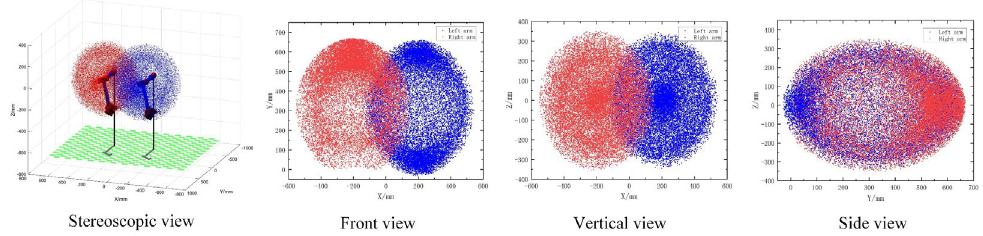
Figure 9. Monte Carlo method collaborative spatial point cloud map.